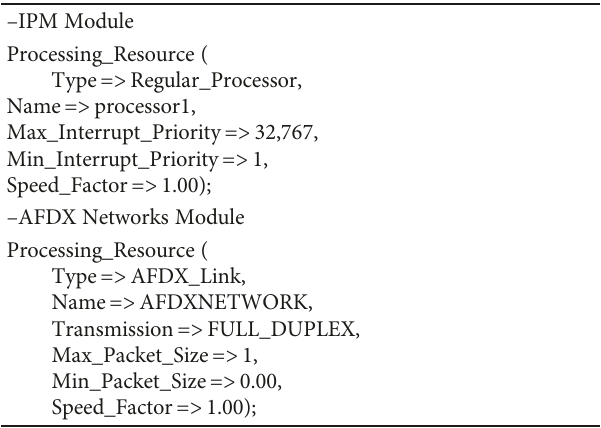
Table 7: Processing_Resource model elements of